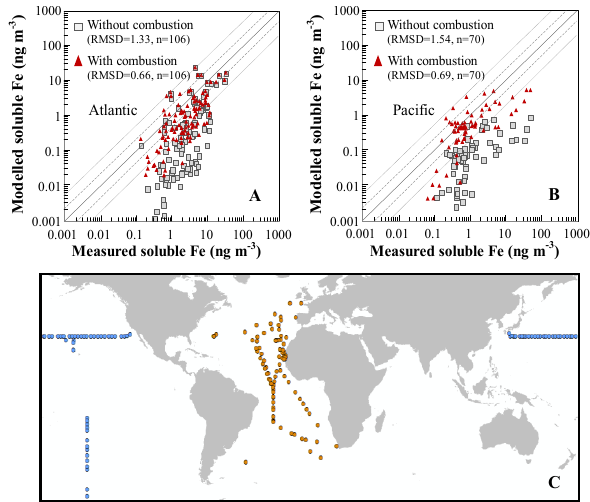
Figure 19 Figure 19. Comparison of modelled and observed soluble Fe con- centrations over the Atlantic (a) and Pacific (b) oceans. Model sim- ulations were run for 2004 and 2005 with the Fe emissions from mineral dust, but without (grey squares) or with (red triangles) the emissions from combustion. Fixed Fe solubilities were applied for Fe from mineral dust (0.44%) and combustion of coal (22.5%), oil (79%) and biomass (18%). The measured daily soluble Fe concentrations in 2004 and 2005 were compiled from the litera- ture (Baker et al., 2007; Sedwick et al., 2007; Buck et al., 2006, 2010). The modelled and observed soluble Fe concentrations were compared on the same days. To evaluate the model performance, the root mean square deviations (RMSD) are computed for log 10 - transformed concentrations. The 1:1 (solid), 1:2 and 2:1 (dashed), and 1:5 and 5:1 (dotted) lines are shown. Locations of the mea- surement sites are shown in (c)